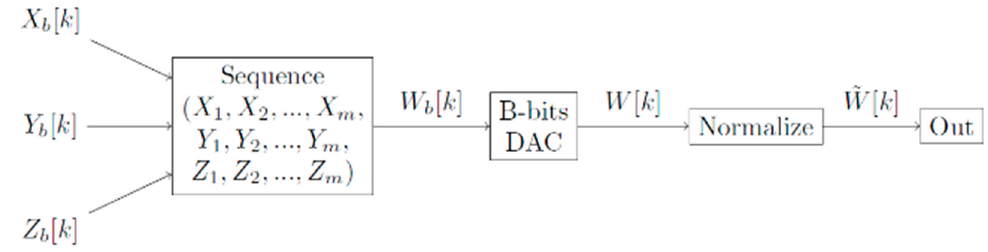
Figure 6. Block diagram of the random number generator implemented in the research.